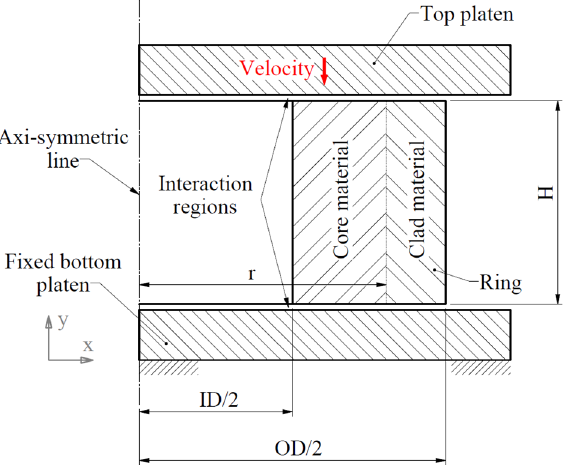
Figure 2. Schematic representation: the ring with laminated layers under dynamic compressive loading.